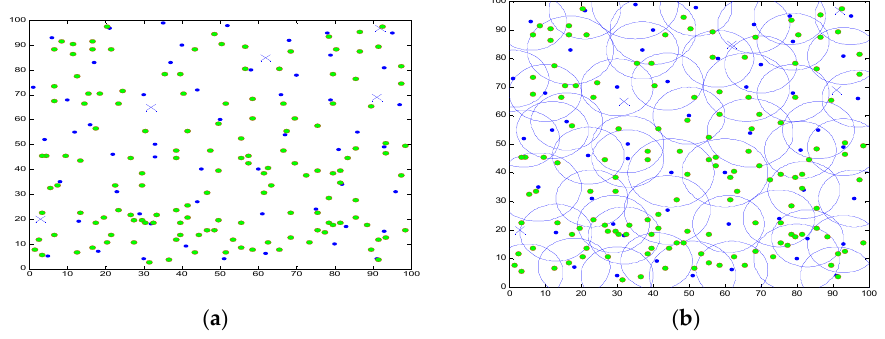
Figure 10. Comparison of the coverage ratio over rounds.